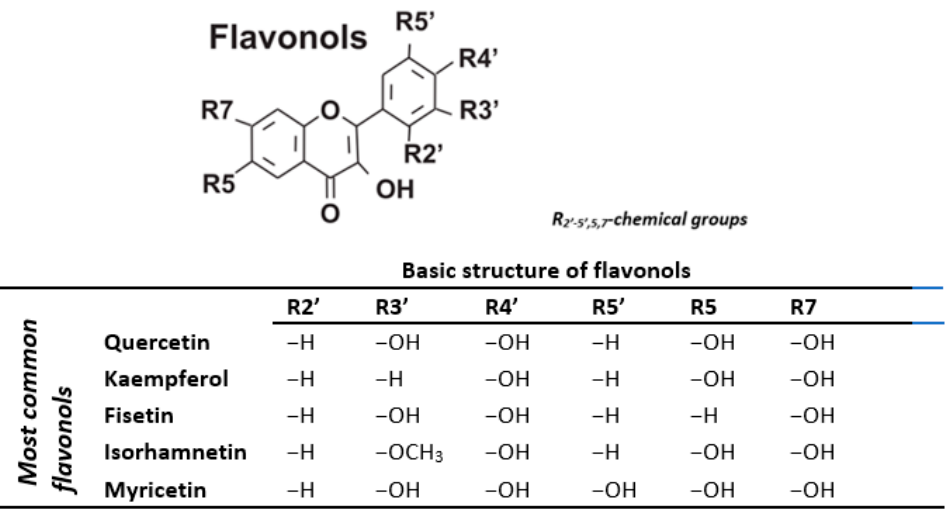
Table 1. Content of flavonols in selected foodstuffs (mg per 100 g of foodstuff), based on [20].